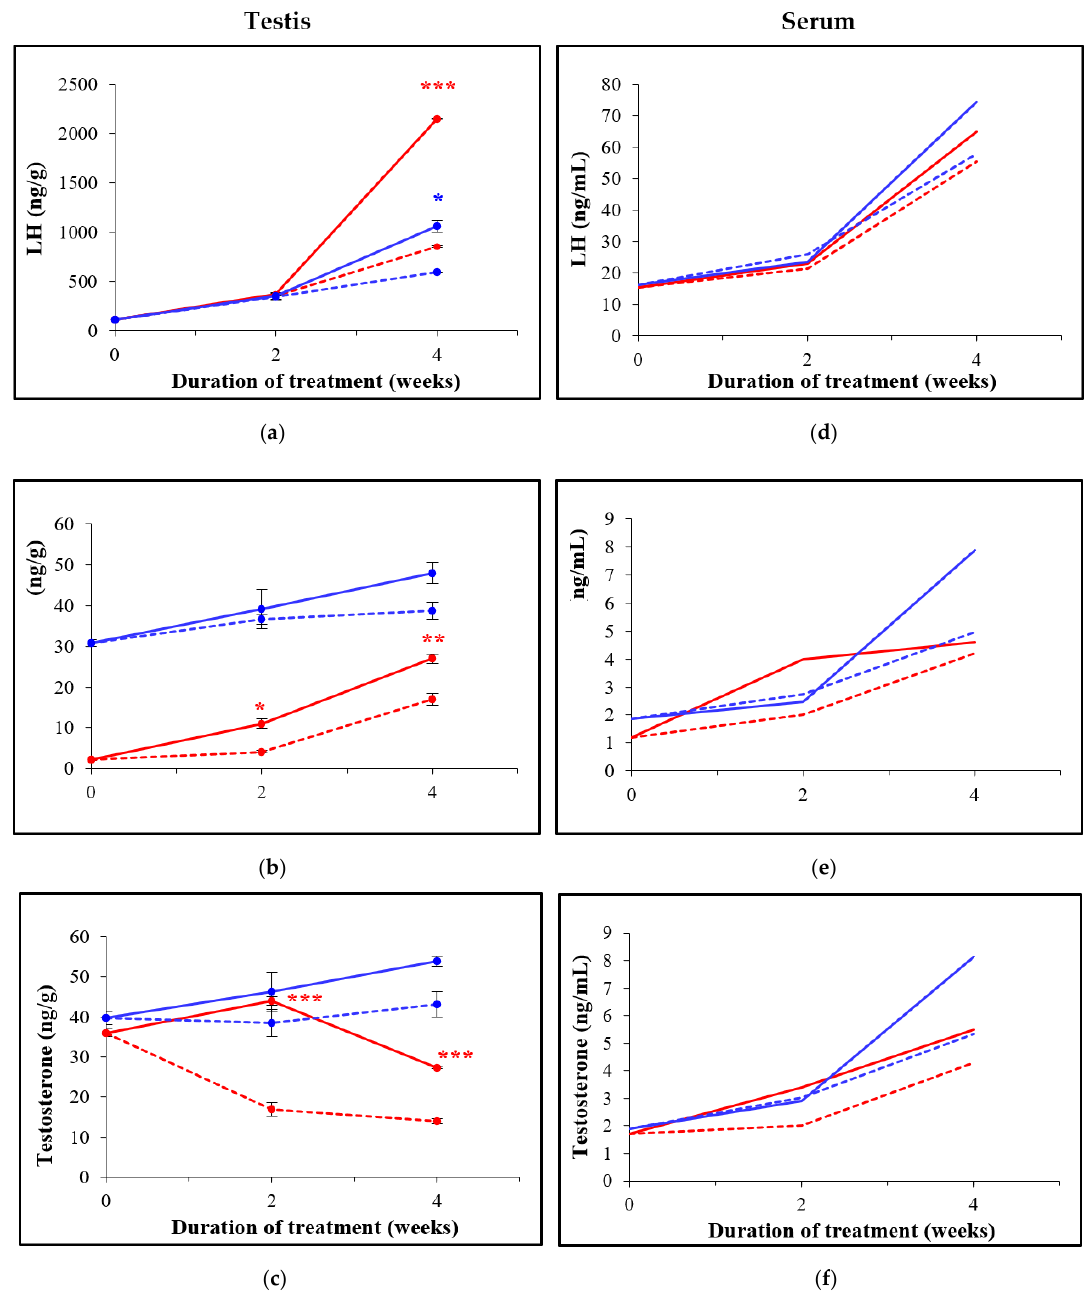
Figure 4. Hormone measurement in males treated with D-Asp (continuous lines) and control males (dotted lines) from 9-week-old (red lines) and 16-week-old males (blue lines) in testes ( a – c ) and in sera ( d – f ). With respect to the hormone levels in the testis, the results are the mean of three samples ( n = 3) and are expressed as mean ± SEM. The hormone levels in serum were measured in triplicates using three samples that were previously pooled. Significant differences between D-Asp-treated and control 9-week-old males are marked with red asterisks as follows: *: p < 0.05, **: p < 0.01, ***: p < 0.001, whereas in D-Asp-treated and control 16-week- old males, this is marked with a blue asterisk as follows: *: p < 0.05.